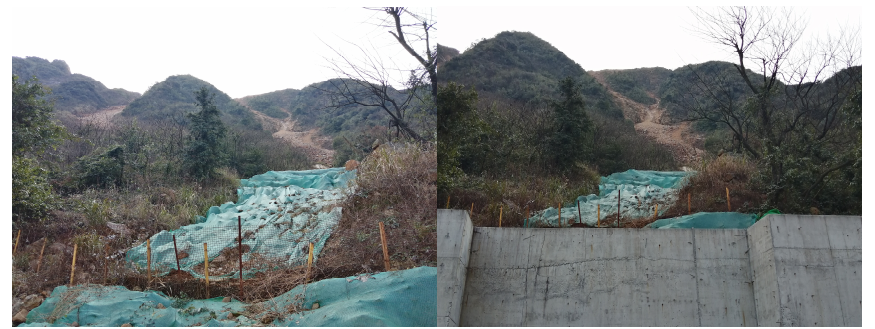
Figure 14. Photos of treatment measures.